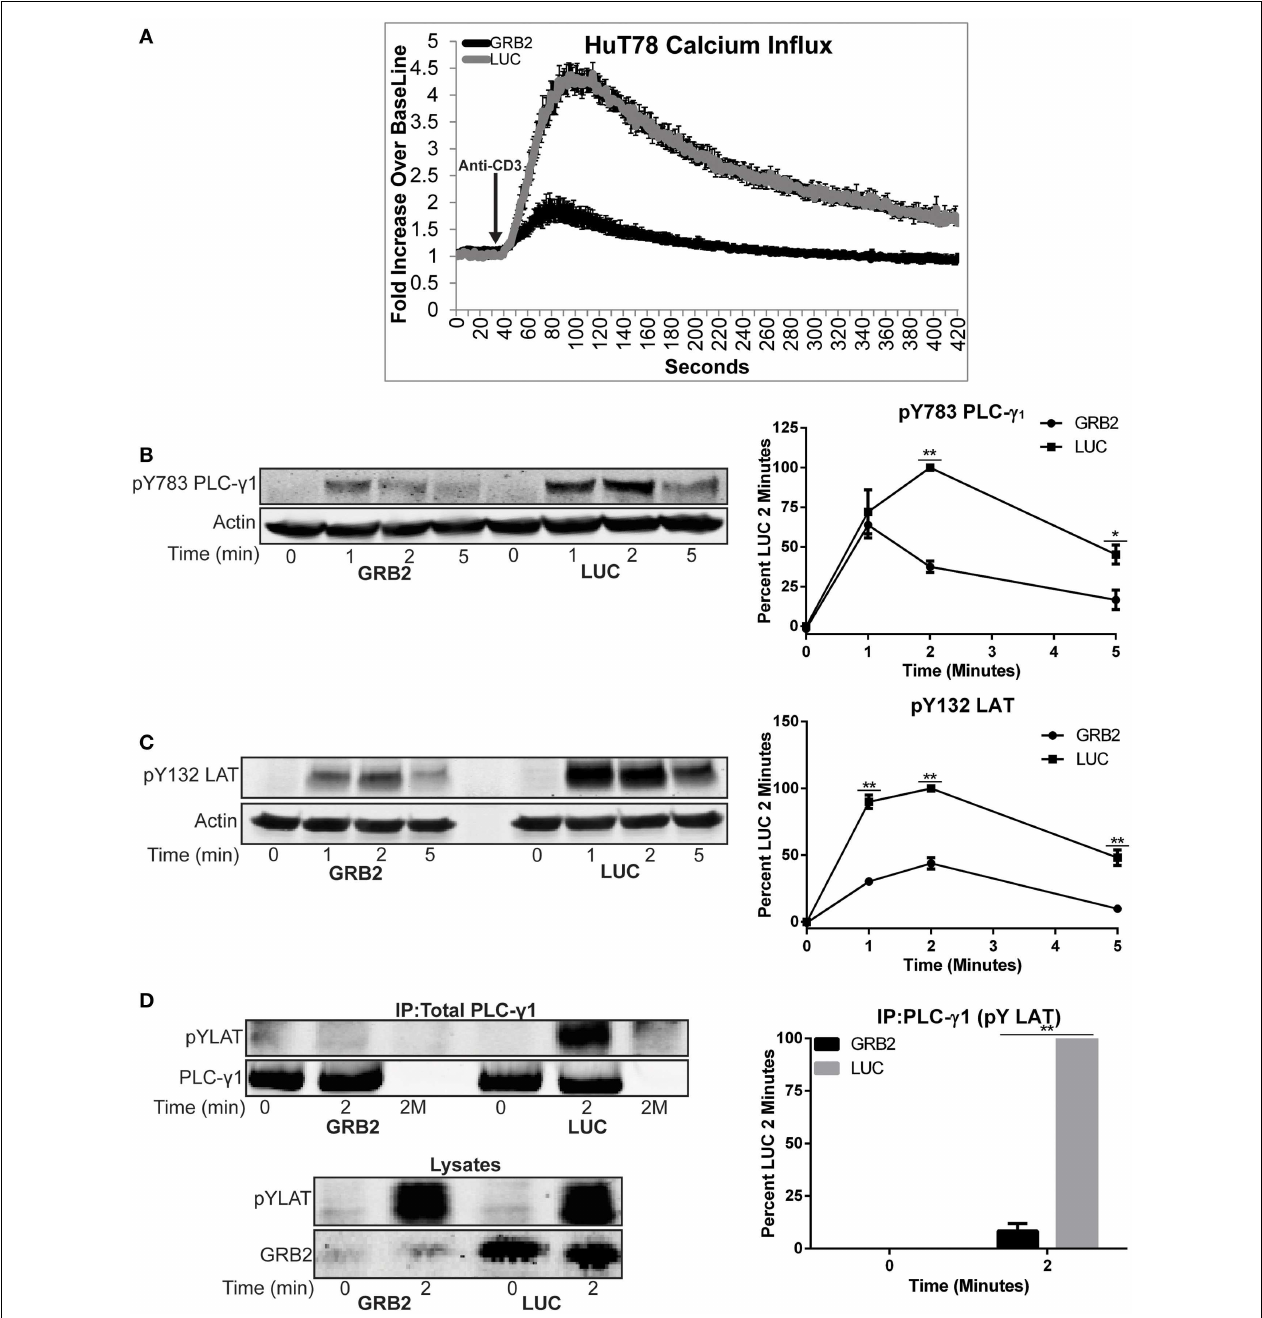
four independent experiments. (C) GRB2 deficient or control HuT78T cells were stimulated as in “ (B) ” and then the protein levels were detected using antibodies against pY132 LAT and actin.The levels of phosphorylation ofY132 was normalized to actin expression and graphed as mean percentage phosphorylation of LUC ± SEM of four replicates. (D) PLC- γ 1 was immunoprecipitated from HuT78T cells stimulated with 2 µ g/mL soluble anti-CD3 for 2min with anti-PLC- γ 1 or no antibody control (2M) and the phosphorylation or binding of specific proteins was assessed by immunoblotting. Data shown is representative of